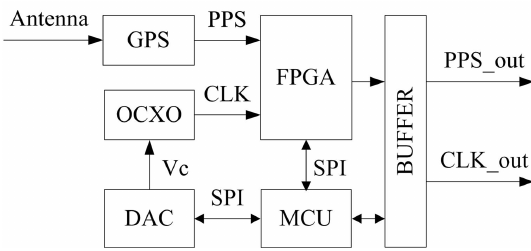
Figure 4. Block diagram of the time synchronization